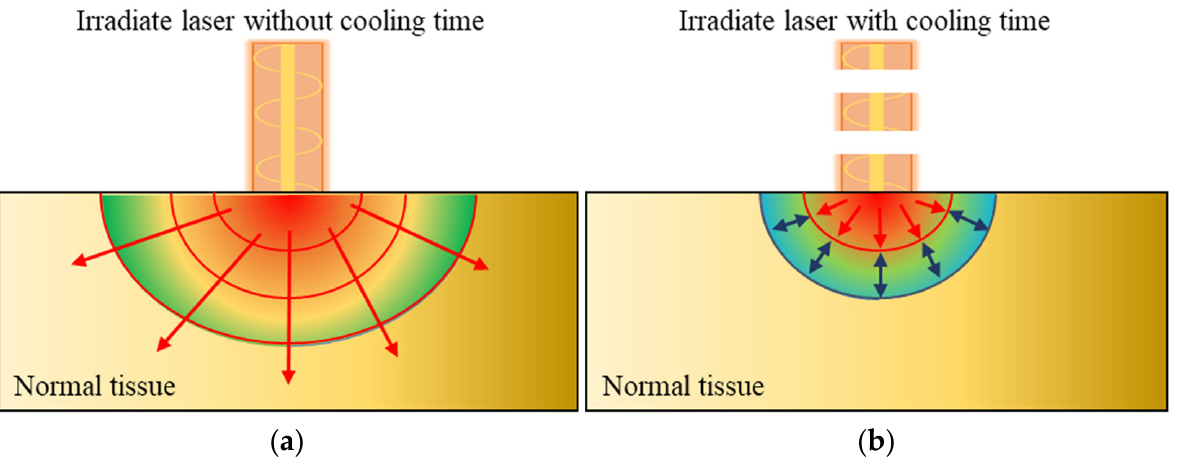
Figure 6. ( a ) Heat transfer in normal tissue; ( b ) thermal confinement effect by applying cooling time.